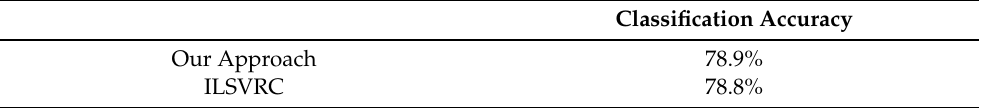
Table 5. Results of classification